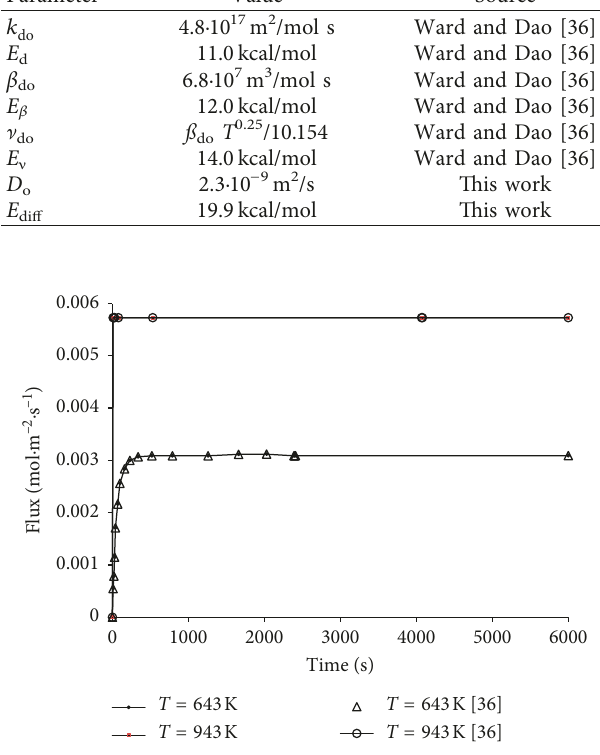
Figure 7: Hydrogen fluxes calculated without sulfur contaminant.